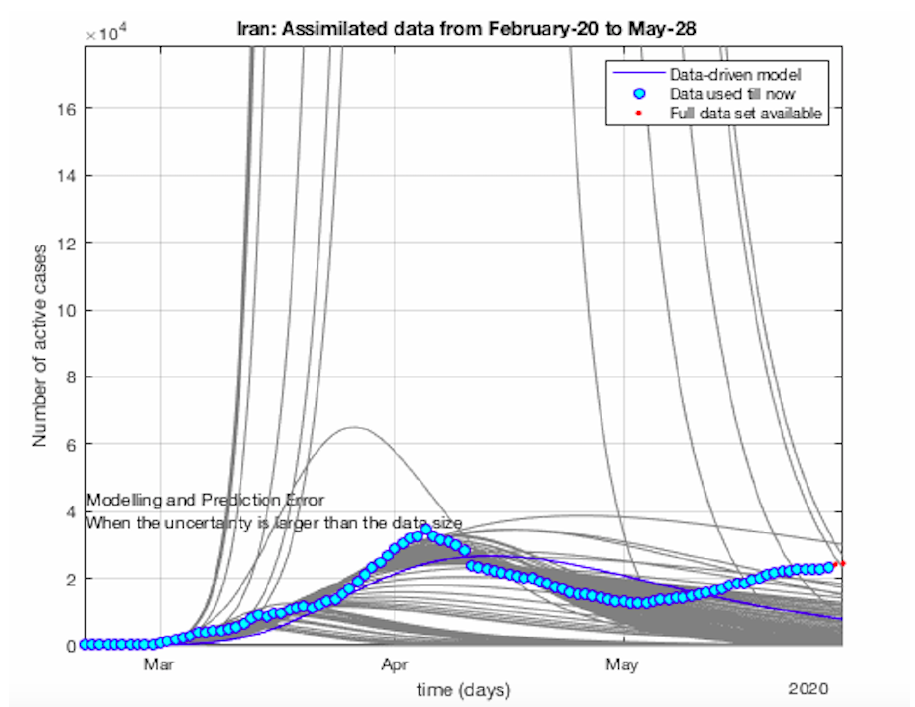
Figure 16. COVID-19 sample of Non-Gaussianity and non-exponential. The plots are obtained by using the data set sequentially till the latest data point. A Non-Gaussianity of the reported active cases and hospitalized cases is observed. The shape of the sequential data-driven curve is clearly not a single